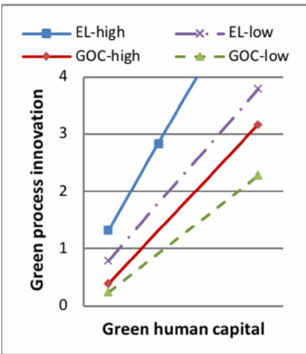
Figure 6. The moderating effect between GHC and GI2.